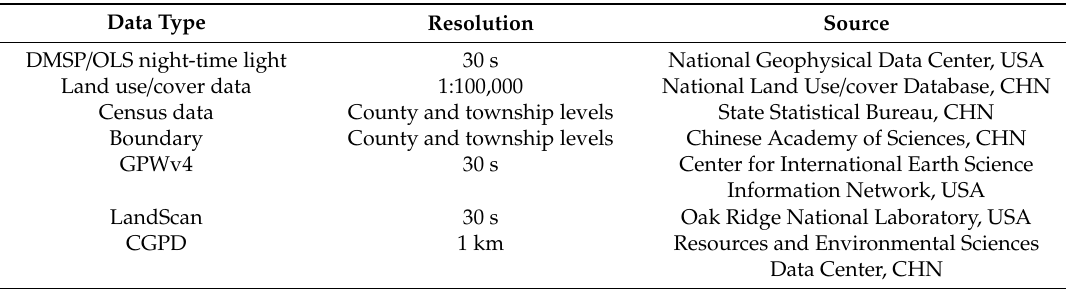
Table 1. List of datasets and